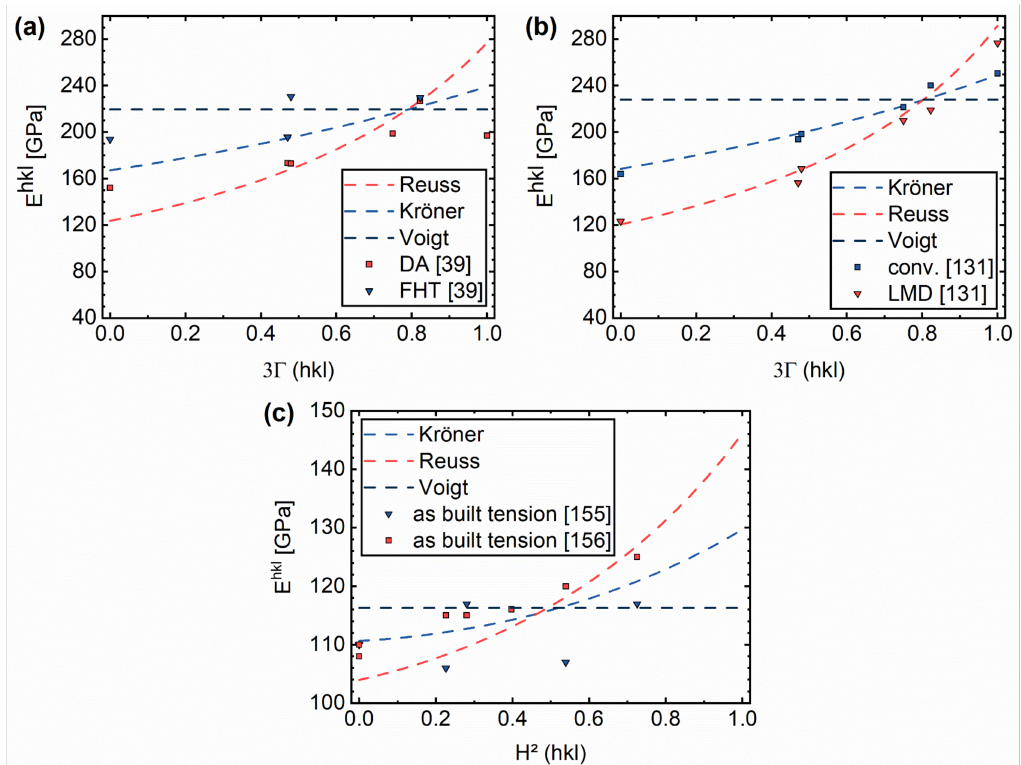
Figure 12. Comparison of the model predictions of Reuss, Voigt and Kröner for Ni-based alloys Inconel 718 ( a ), Inconel 625 ( b ) [39] and Ti6Al4V [155,156] ( c